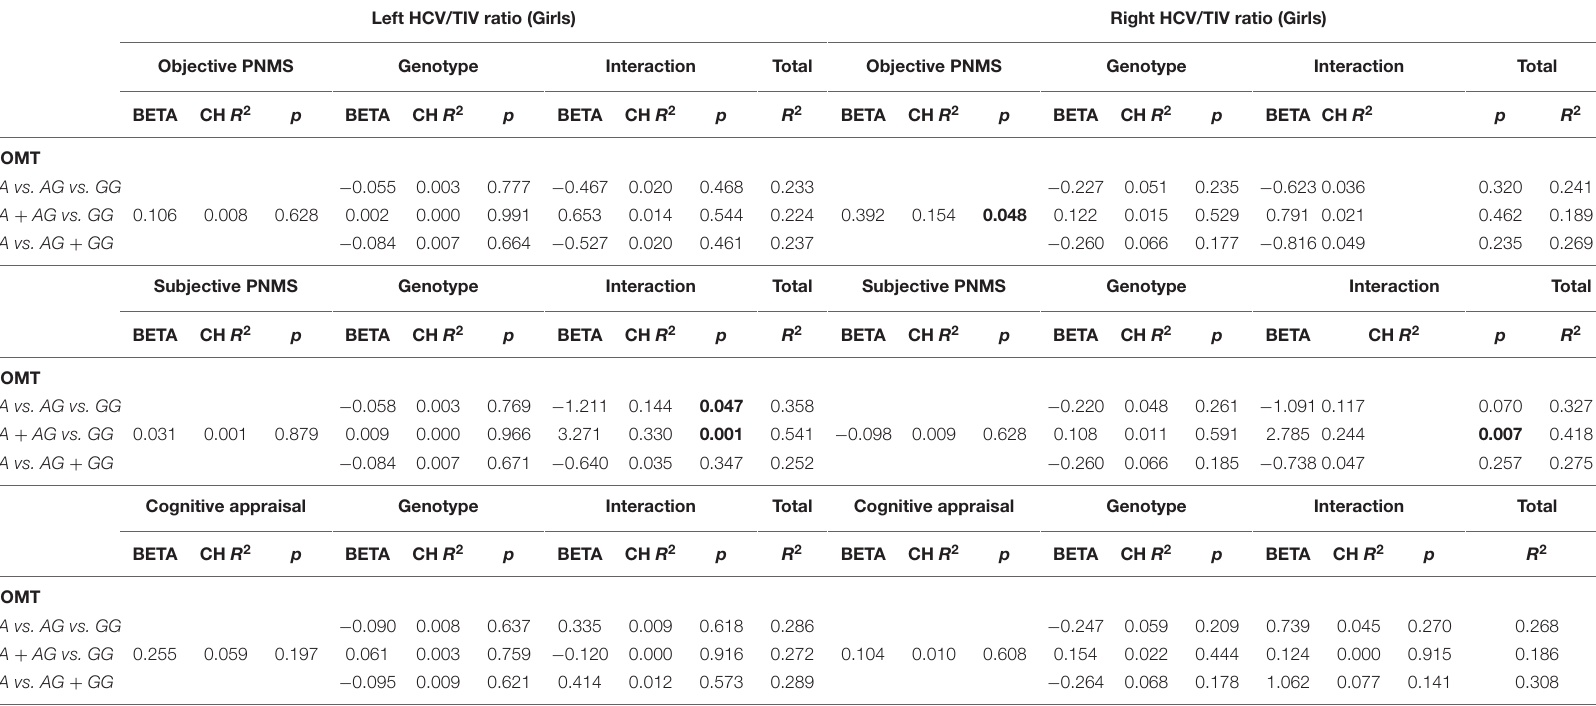
TABLE 6 | Effect of PNMS, genotype and gene-by-environment interaction on HCV/TIC volume in girls, controlling for socioeconomic status With left